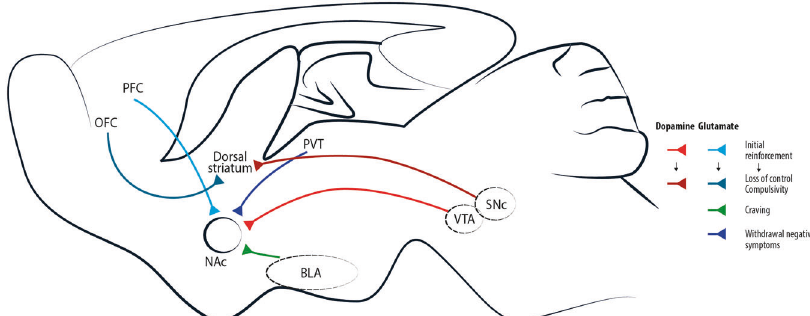
Fig. 1 Simpli fi ed brain circuits implicated in drug addiction. Addictive drugs of different types have a common effect of increasing levels of dopamine released by neurons projecting from the ventral tegmental area (VTA). This effect is central for initial drug reinforcement. Notably, drug taking with initial reinforcement involves a potentiation of the projection from prefrontal cortex (PFC) to nucleus accumbens (NAc), while other glutamatergic projections are mostly involved in craving, like basolateral amygdala (BLA)-NAc projection, or in withdrawal/ negative symptoms, like paraventricular thalamus (PVT)-NAc projection. With increasing administration of drugs of abuse and progressive shift toward compulsive abuse, the dorsal (dorso-lateral) striatum seems more and more implicated, with dopaminergic cells involved shifting progressively from the VTA to the substantia nigra pars compacta (SNc) [4]. Recently, data acquired through optogenetic dopamine neuron self-stimulation suggested prominent synaptic strengthening of the orbitofrontal cortex (OFC) to dorsal (dorso-medial) striatum projection in compulsive mice